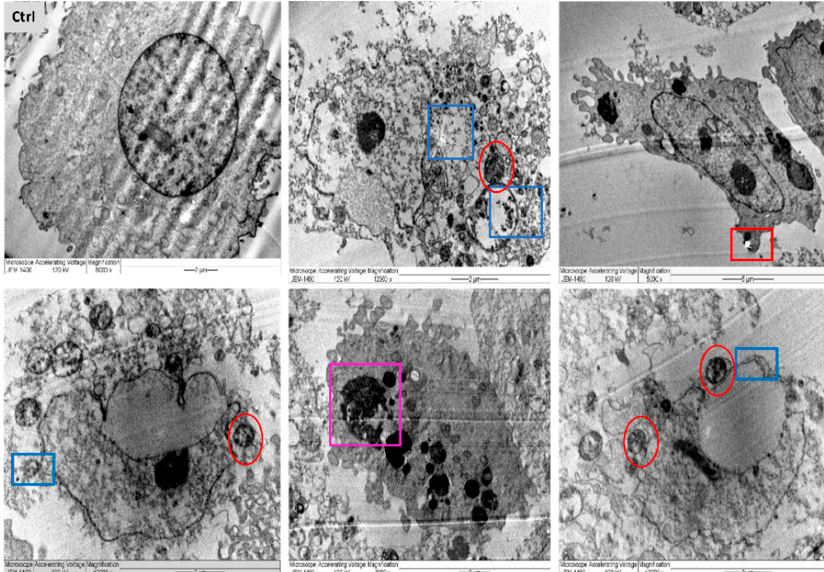
Figure 14. TEM images of MDA-MB-231 cell lines, where untreated cell (Ctrl) exhibiting rounded shape cell with complete organelle and nucleus. Image magnification ×6.000; bar 2 µm. Other images at varied magnification show the ultrastructural alteration in cell treated with R-AgNPs displaying early apoptosis characteristics such as: chromatin condensation and over whole cell shrinkage as well as late apoptosis: lipid droplet (red square), peroxisomes (yellow square) and enlarged mitochondria (yellow circle), damaged mitochondria (red circle) and condensed nucleus (Purple square). Damaged cancerous cells are clearly observed with R-AgNPs located in the cytoplasm, outer cell and nucleus membranes (blue squares).